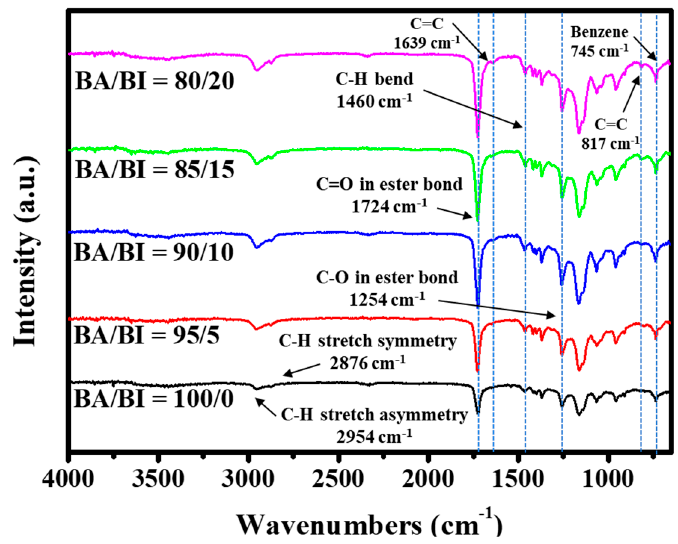
Figure 2. FT-IR spectra of PBABI copolyesters.